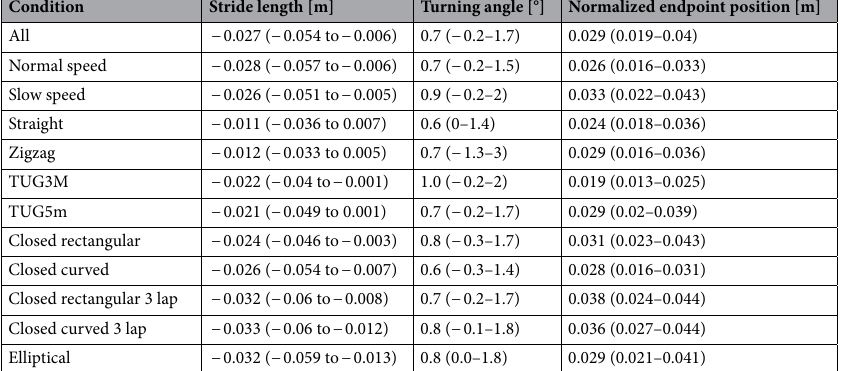
Table 4. Evaluation results of the estimation error of the proposed method compared to the golden standard in the stride length the turning angle, and the normalized endpoint position, respectively. These results are evaluated under the two walking speed conditions and nine walking route